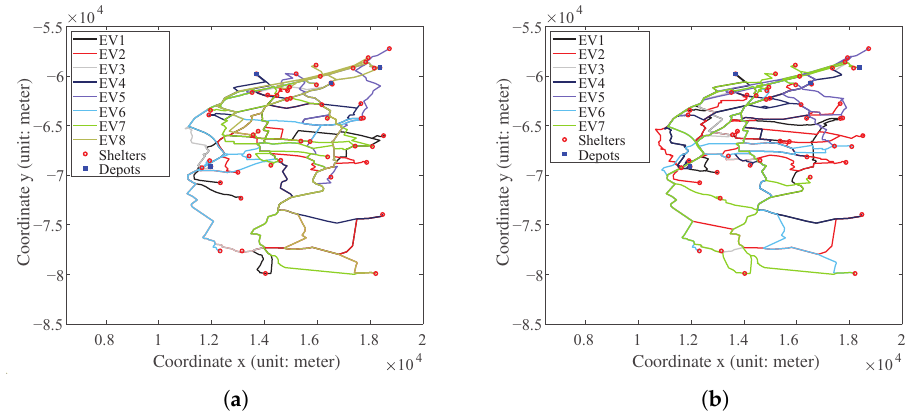
Figure 8. Optimal delivery scheme of different time windows for case 1. ( a ) The delivery scheme of TW1 for case 1. ( b ) The delivery scheme of TW2 for case 1.